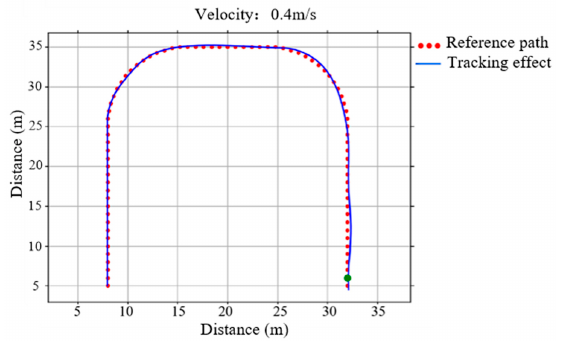
Figure 23. E ff ect of path tracking. Figure 23. Effect of path